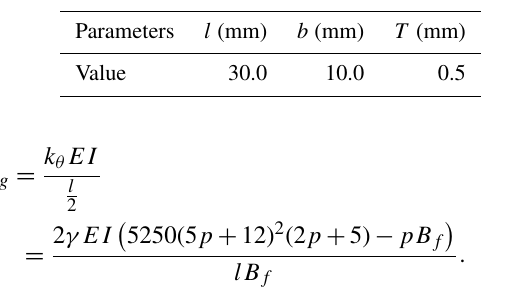
Table 1. Geometric parameters of the fixed-guided beam flexure. Table 2. The maximum error for the tip point